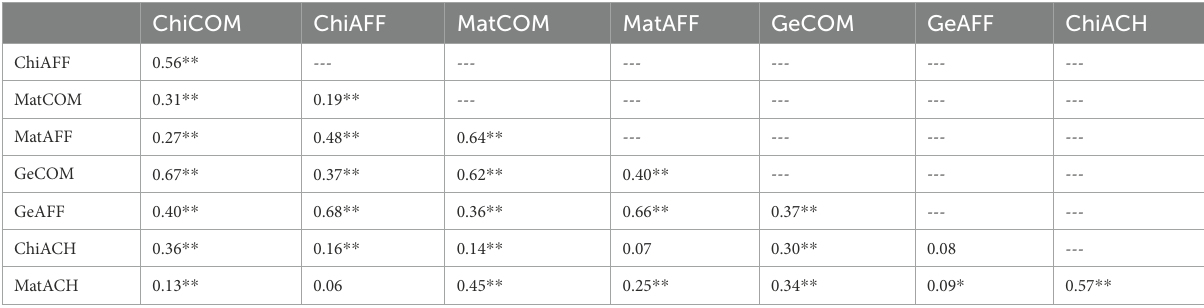
TABLE 7 Factor correlations at